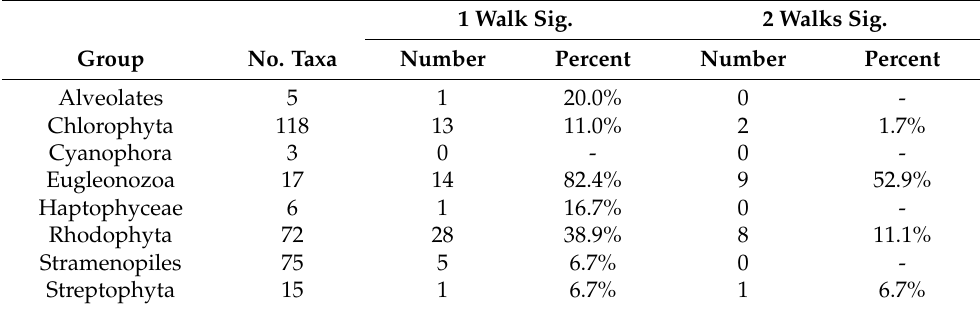
Table 2. Number of genomes showing significant walk deviation when I AT –I GC is constrained to less than 5% of the genome length. 1 Walk